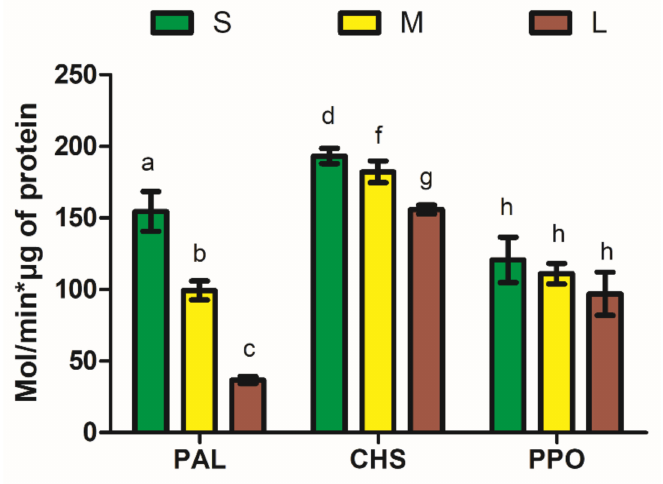
Figure 2. Enzymatic activities in avocado peel extracts (APEs) of small (S), medium (M), and large (L) avocados. Abbreviations: PAL—phenylalanine ammonia-lyase; CHS—chalcone synthase; PPO—polyphenol oxidase. Di ff erent letters over each column indicate significant di ff erences according to Tukey’s test ( p <